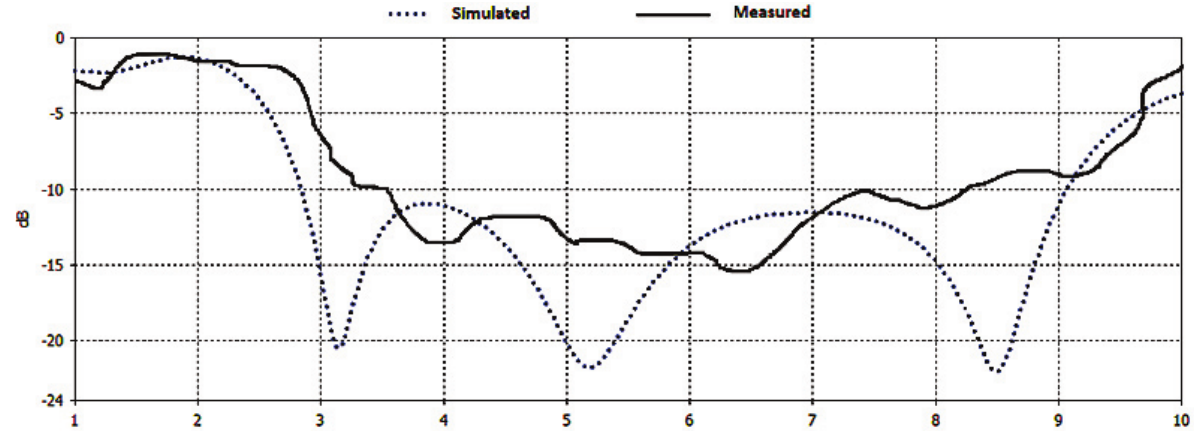
Fig. 11. The simulated and measured S11 consequences for the designed UWB